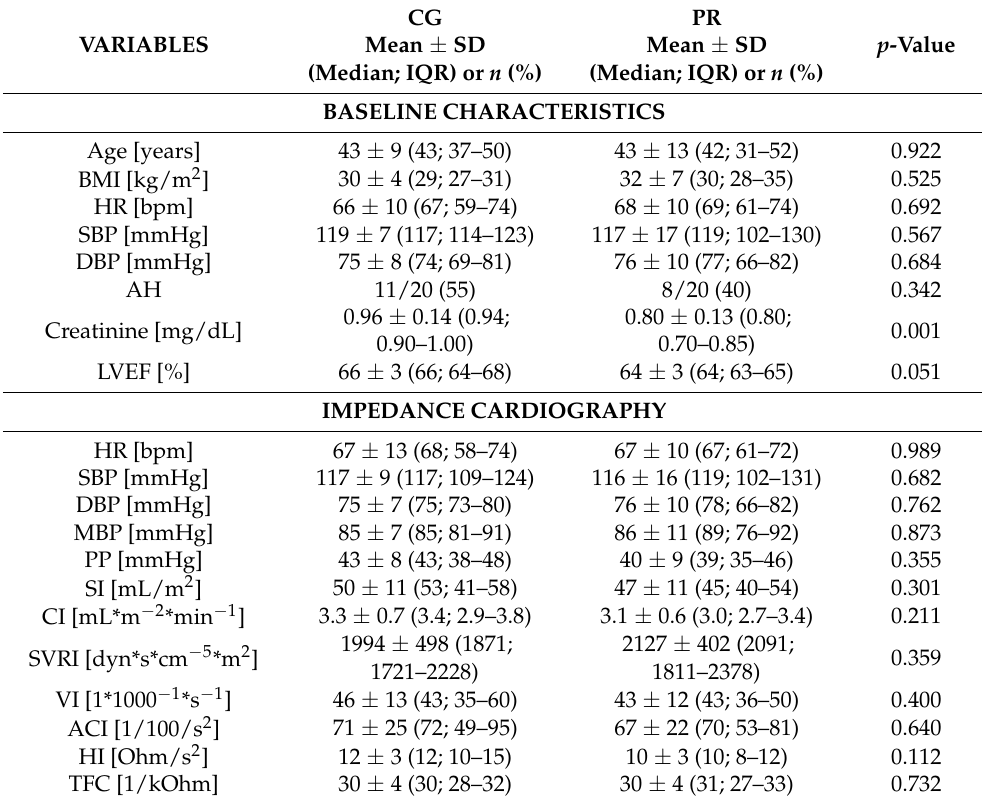
Table 2. The comparison of routinely evaluated parameters and the hemodynamic parameters measured using impedance cardiography in the control group (CG) and the group of patients with prolactinoma (PR).